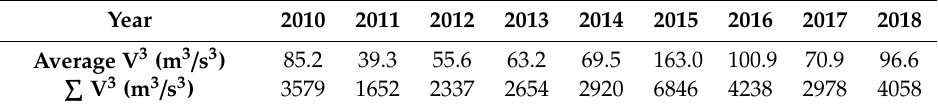
Table 4. Wind exposure in the period 2010–2018: top row—the averaged values of V 3 , bottom—the integrated value of V 3 over the total